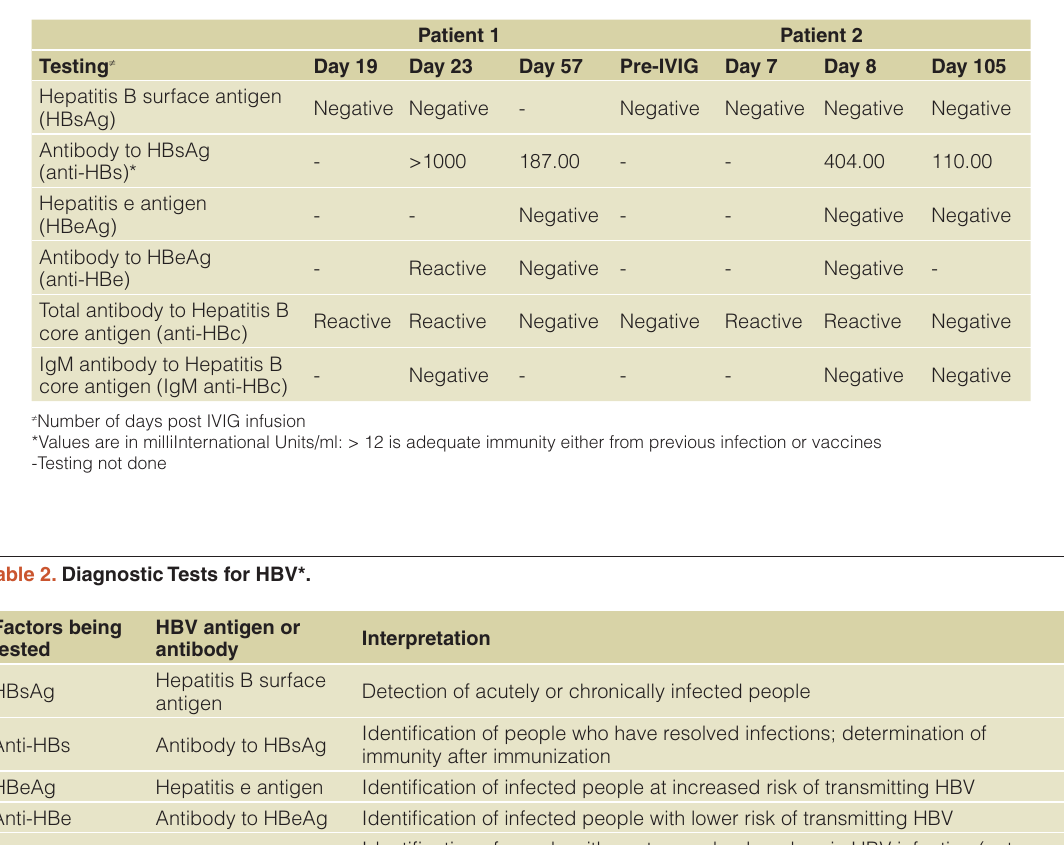
Table 1. Patient 1 and 2 hepatitis B diagnostic tests.